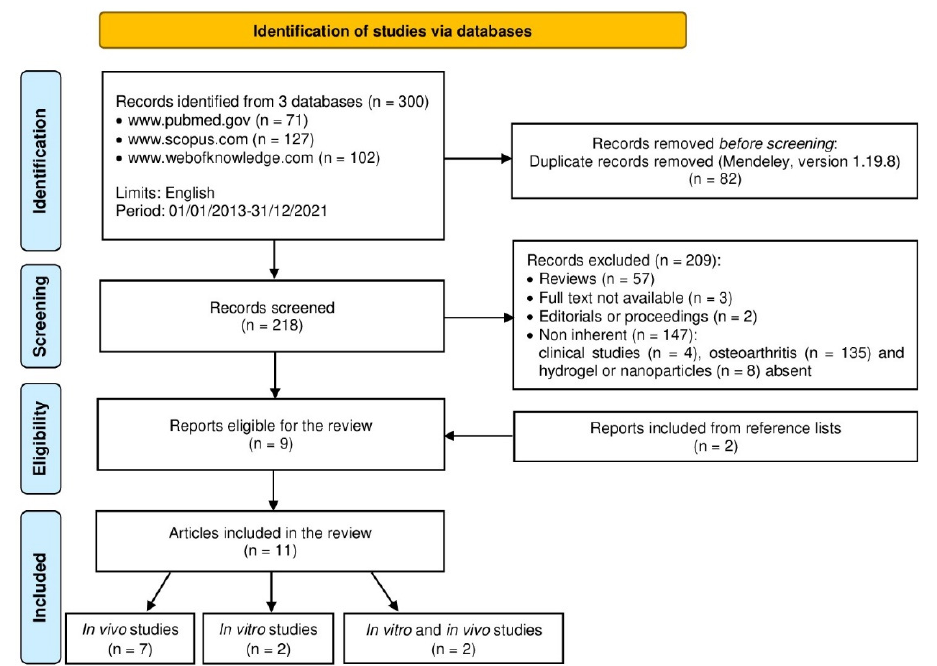
Figure 1. Search strategy according to the Preferred Reporting Items for Systematic Reviews and Meta-Analyses (PRISMA) guidelines.